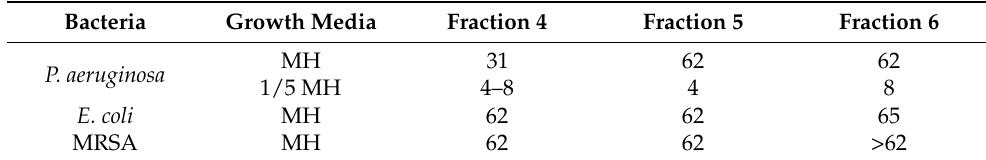
Table 1. Minimum inhibitory concentrations in µ